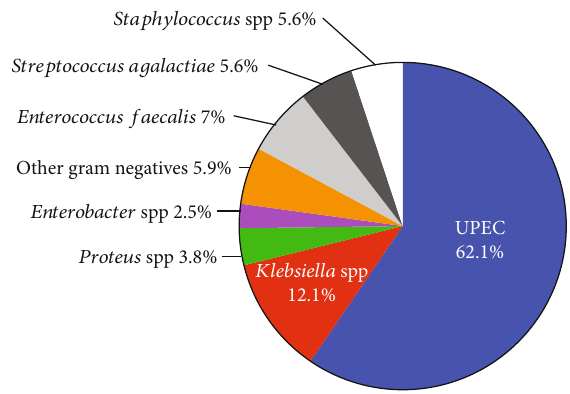
Figure 3: Microbial etiology of UTI in diabetic